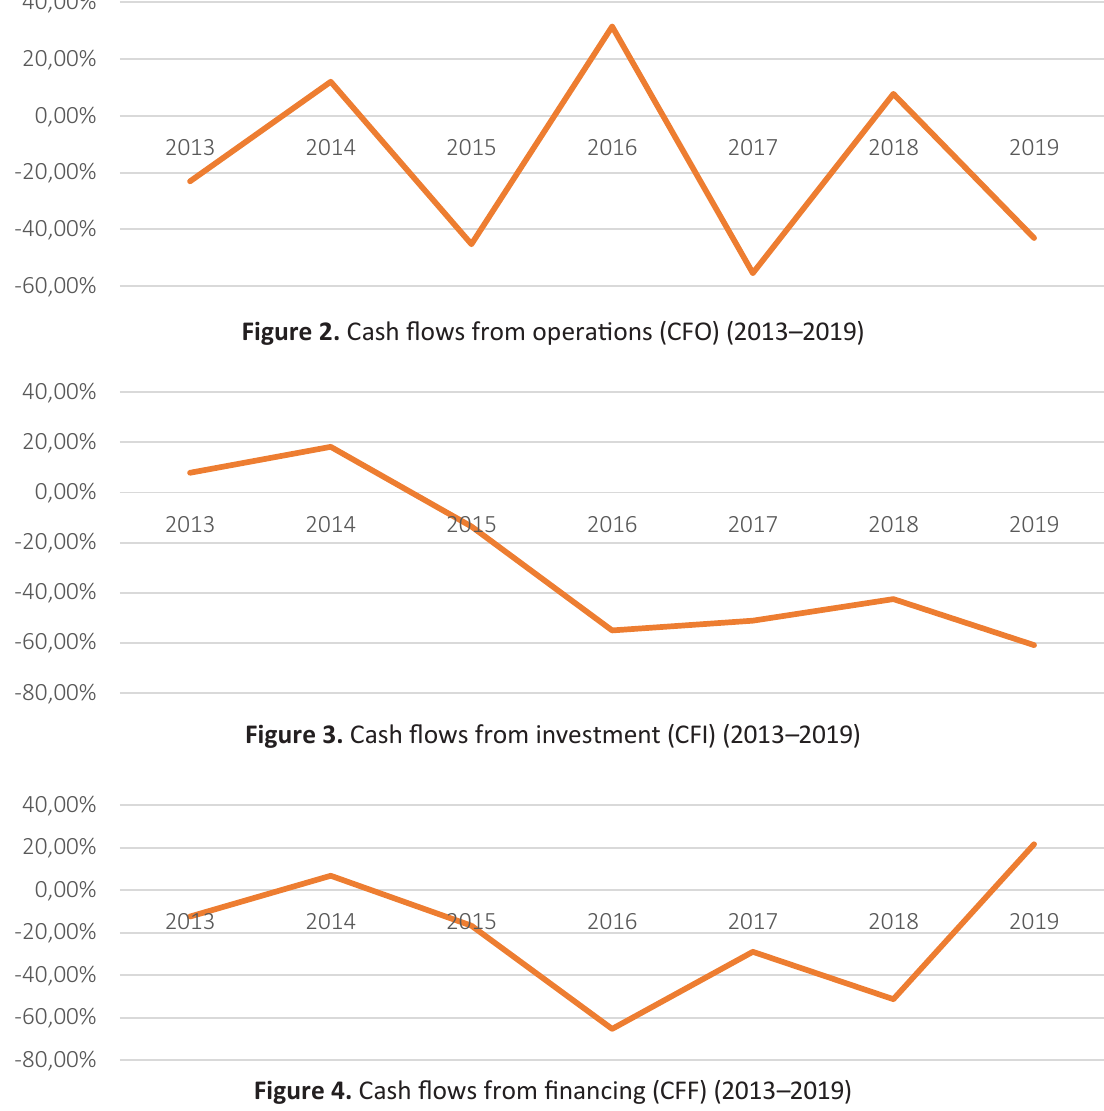
Figure 4. Cash flows from financing (CFF)